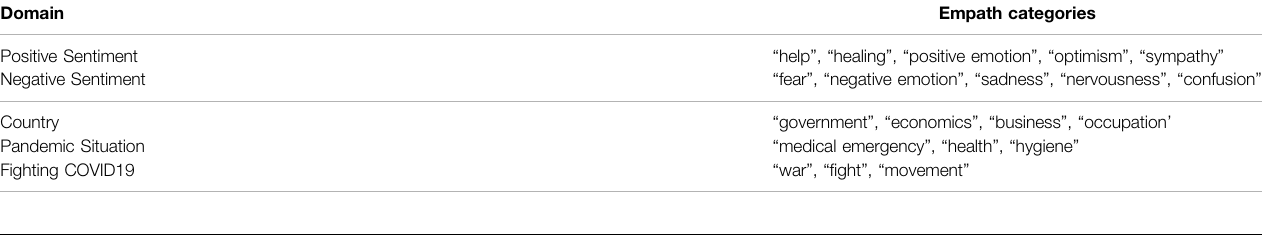
TABLE 3 | Important modi fi cations to Empath